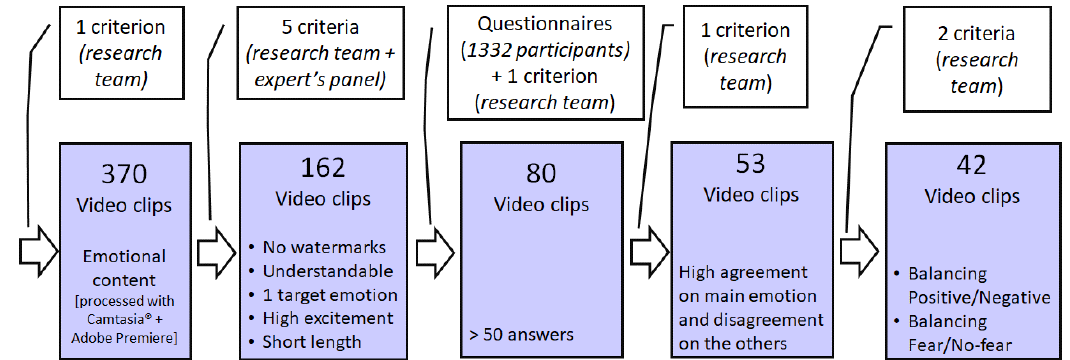
Figure 2. Processing of audiovisual materials in the process of creation a balanced set of video clips for fear/no-fear detection system.